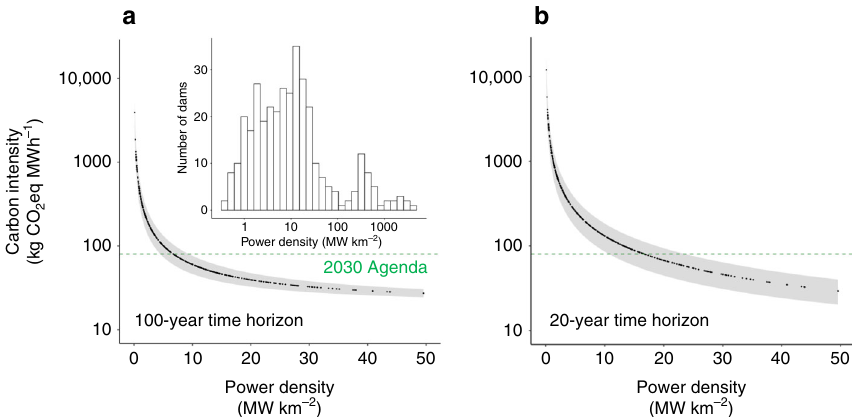
Fig. 4 Low-carbon power densities for Amazon hydropower. Power density is a key determinant of carbon intensity. We plotted the functional relationship between power density and carbon intensity for existing and proposed Amazon dams over a a 100-year and b 20-year time horizon. Shaded areas re fl ect uncertainty about GHG fl uxes (95% bootstrap con fi dence region, see Methods). Points below the green line indicate projects with carbon intensities that satisfy the reference carbon intensity for sustainable electricity production (80 kg CO 2 eq MWh − 1 ). To improve visualization, we omitted projects with power densities above 50 MW km − 2 ( ≈ 25% of the dams). The inset fi gure in ( a ) shows the frequency distribution of the power densities of all